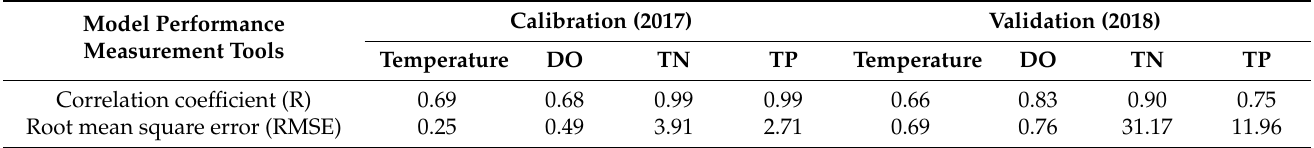
Table 3. The QUAL2K model performance for the calibration and validation period.